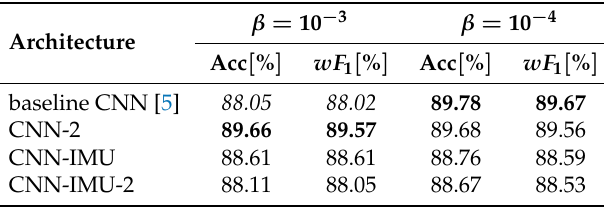
Table 7. Validation accuracies and Weighted F1 for the architectures on the Opportunity-Locomotion dataset using two learning rates during training.